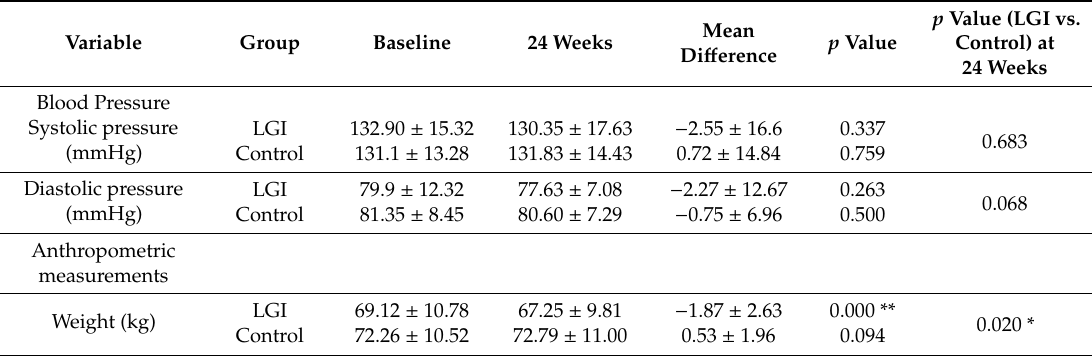
Table 4. Comparison of mean ± SD of the variables at baseline and 24 weeks after intervention between